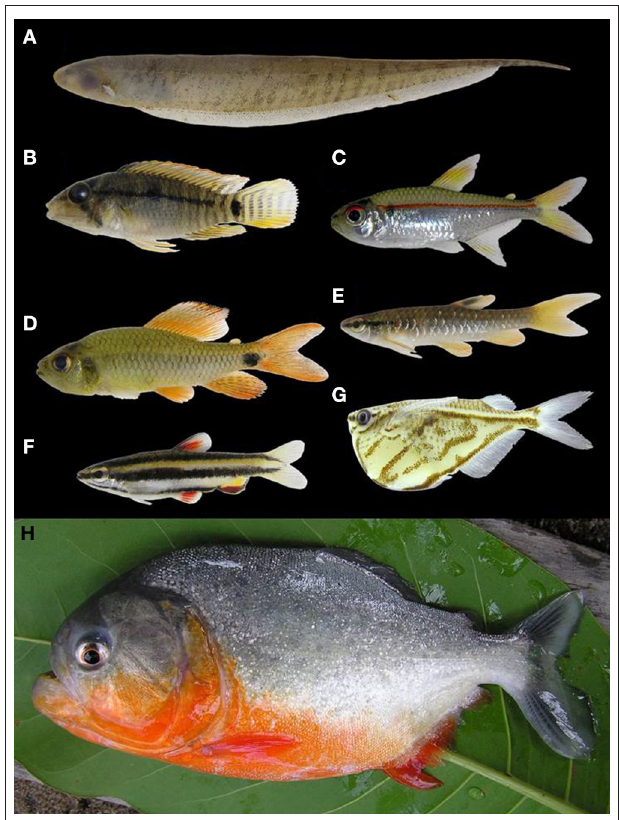
FIGURE 6 | Examples of fishes found in the Rupununi, Guyana. (A) Brachyhypopomus pinnicaudatus , (B) Apistogramma steindachneri , (C) Hemigrammus erythrozonus , (D) Crenuchus spilurus , (E) Pyrrhulina stoli , (F) Nannostomus marginatus , (G) Carnegiella strigata , (H) Pygocentrus nattereri . Photos by: P.